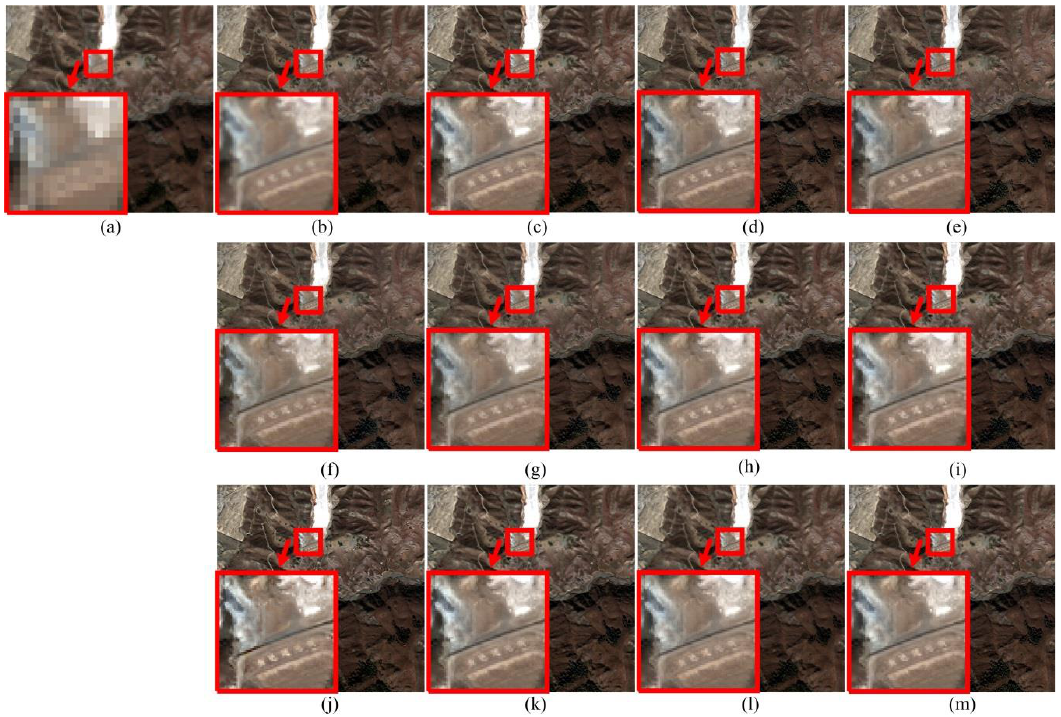
Figure 14. Pansharpening results of Xinjiang dataset. ( a ) MS. ( b ) Ground-truth image. ( c ) PPCNN. ( d ) GS. ( e ) PCA. ( f ) BT. ( g ) IHS. ( h ) ATWT. ( i ) AWLP. ( j ) CBD. ( k ) MOF. ( l ) RAWLP. ( m ) FSR.